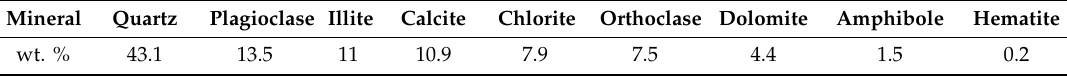
Table 3. Mineralogical composition of the loess that was used in the experiment.